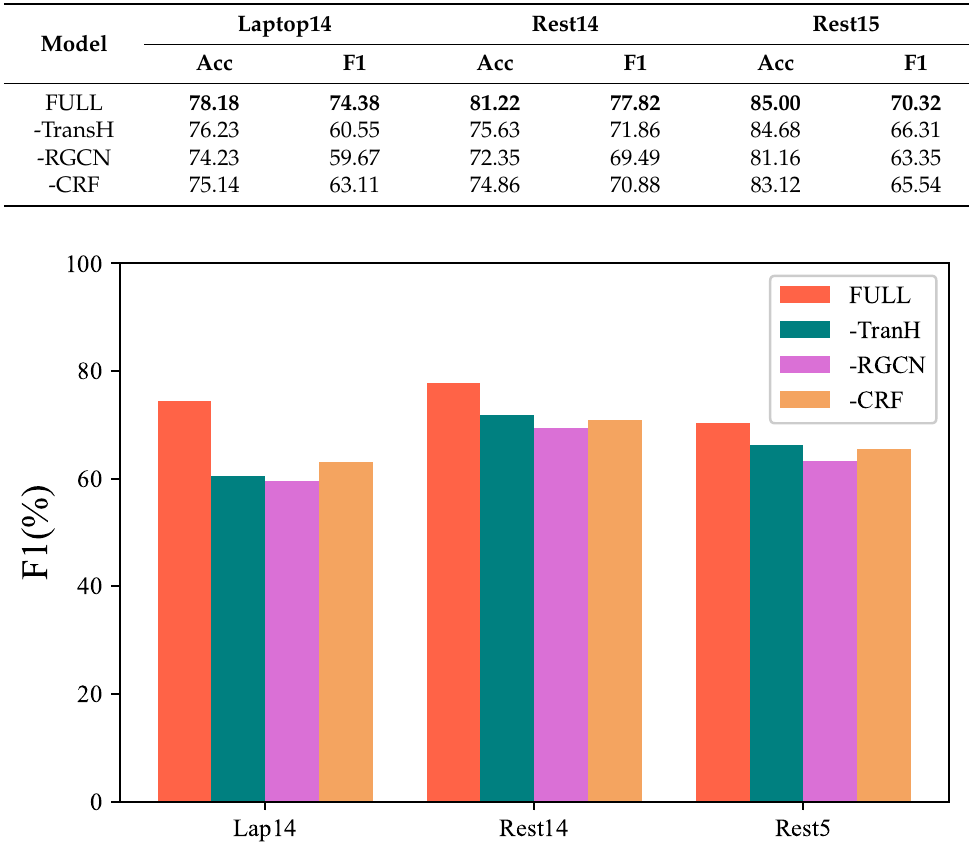
Figure 5. The effect of missing different modules on the three